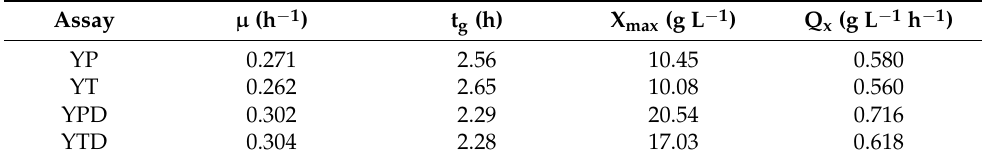
Table 3. Growth parameters of Y. lipolytica IMUFRJ 50682 in different media at 28 ◦ C and 250 rpm.